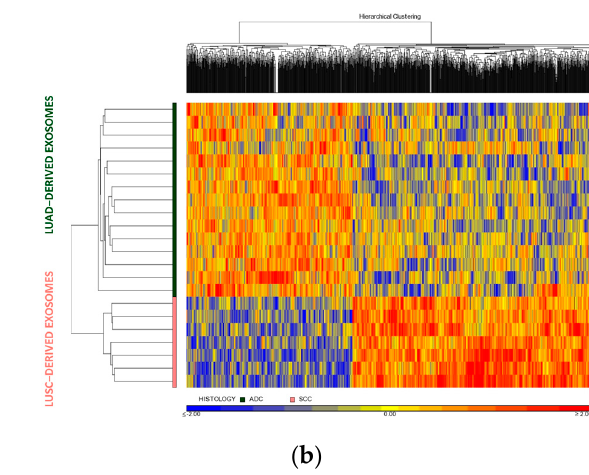
Figure 3. Transcriptomic microarray analysis of cargo of tumor cell culture-derived exosomes. ( a ) PCA plot of H1650, H1975, H2228, SW900, FIS 301 and FIS 343 exosome samples under 2D and 3D conditions (using two biological replicates for each sample) distributed according to histology. ( b ) Hierarchical cluster analysis of differentially expressed probes between LUAD and LUSC. Red color represents overexpression and blue represents underexpression. Rows correspond to the exosome samples analyzed while columns represent the probes detected throughout the samples. Table 1. Main DEGs for each histology screened using Clariom D assays.